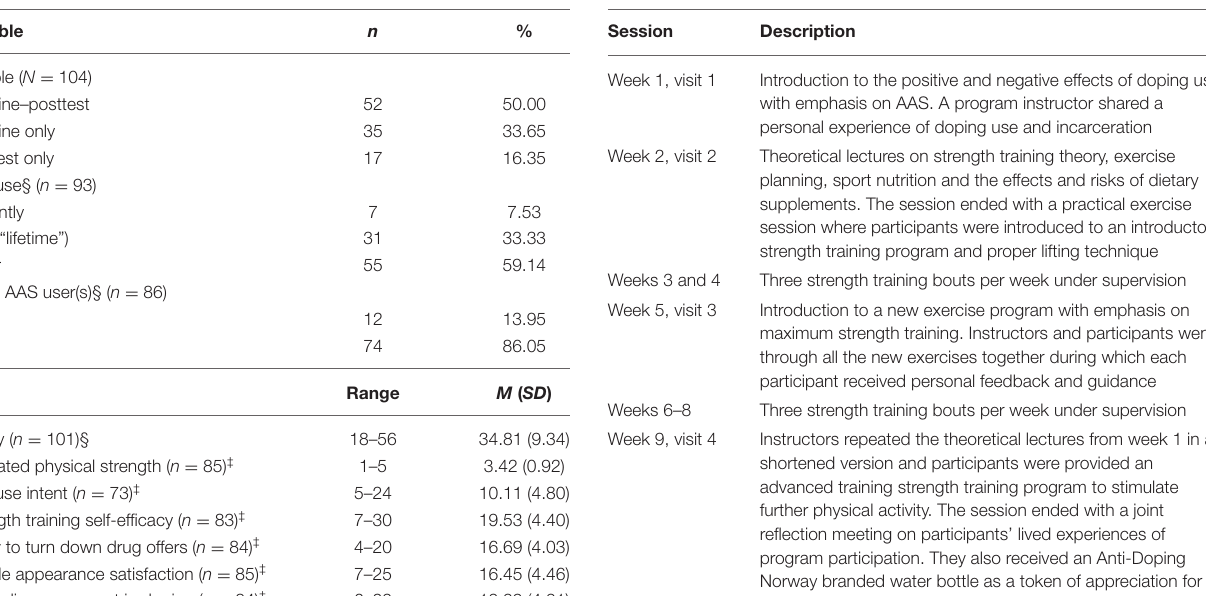
TABLE 1 | Characteristics of the study sample ( N = 104). TABLE 2 | Overview of the Hercules prison